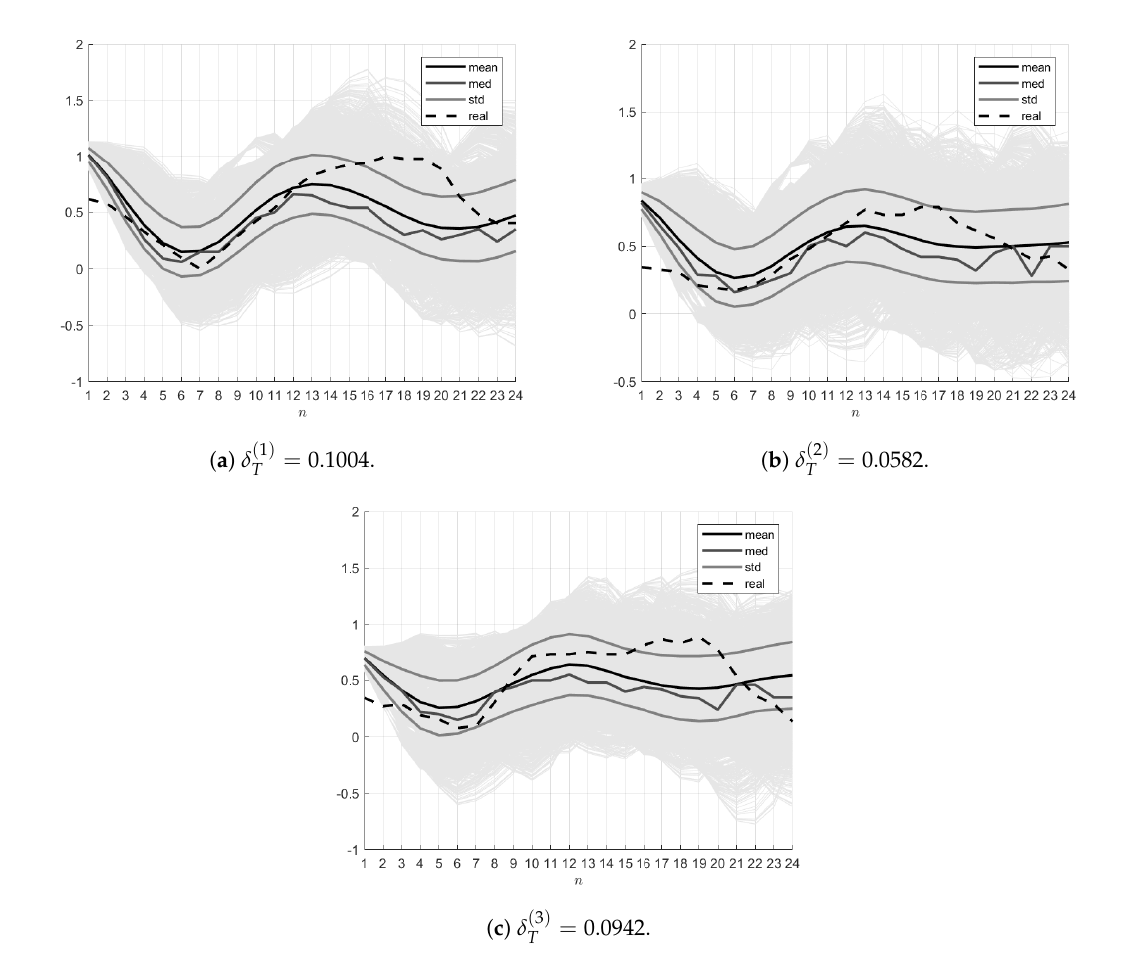
Figure 5. Ensembles of T ξ model.